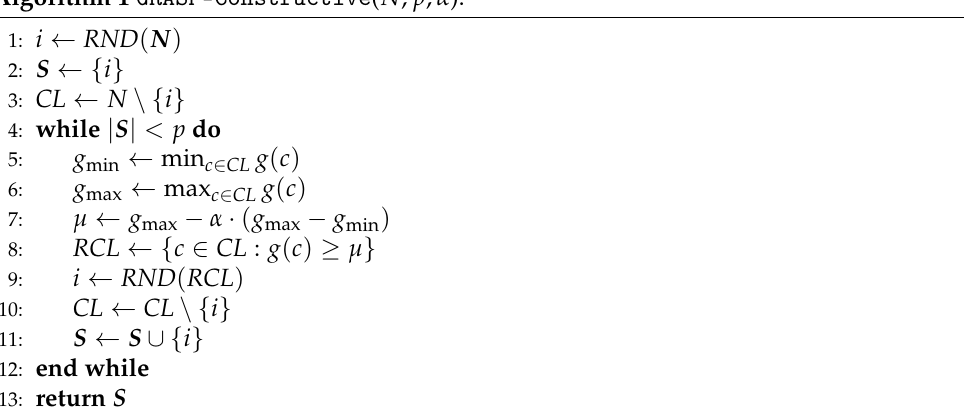
Algorithm 1 GRASP-Constructive ( N , p , α